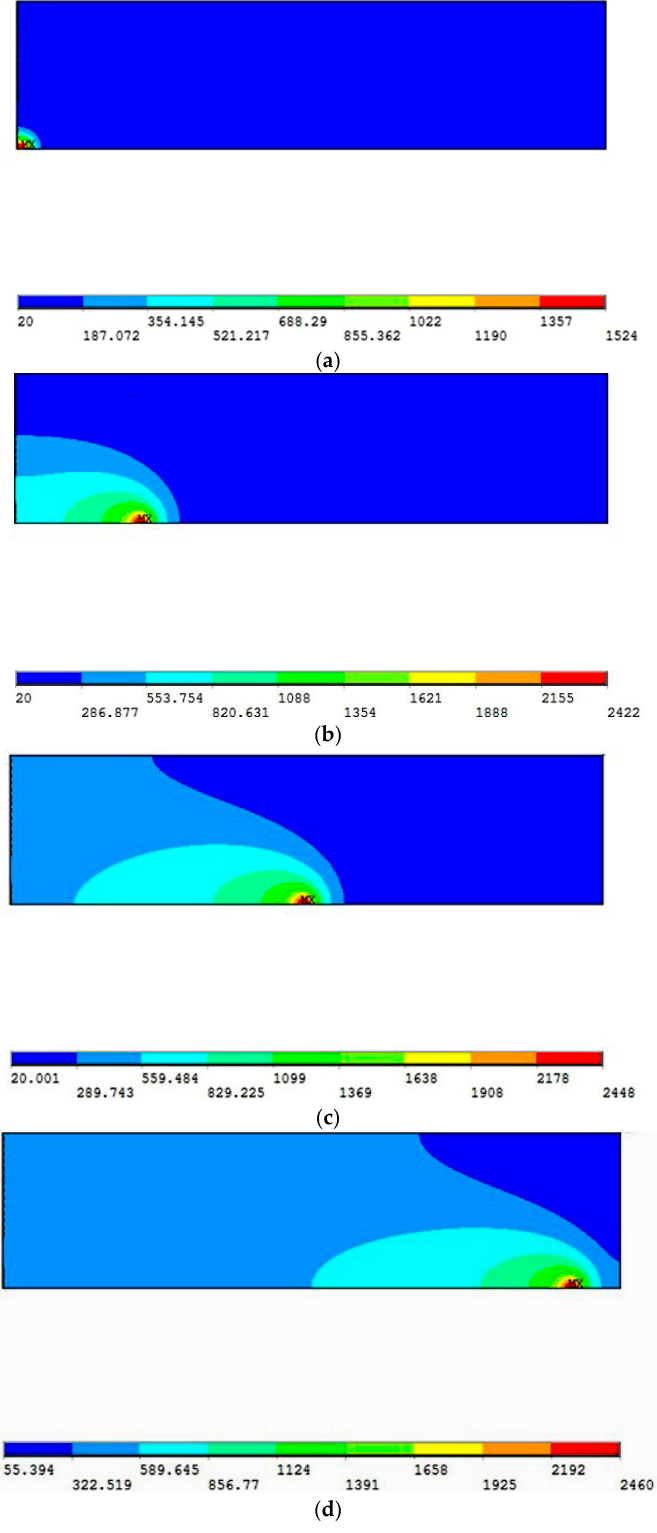
Figure 4. The temperature fields at different times. ( a ) t = 0.5 s; ( b ) t = 15 s; ( c ) t = 35 s; ( d ) t = 65 s.